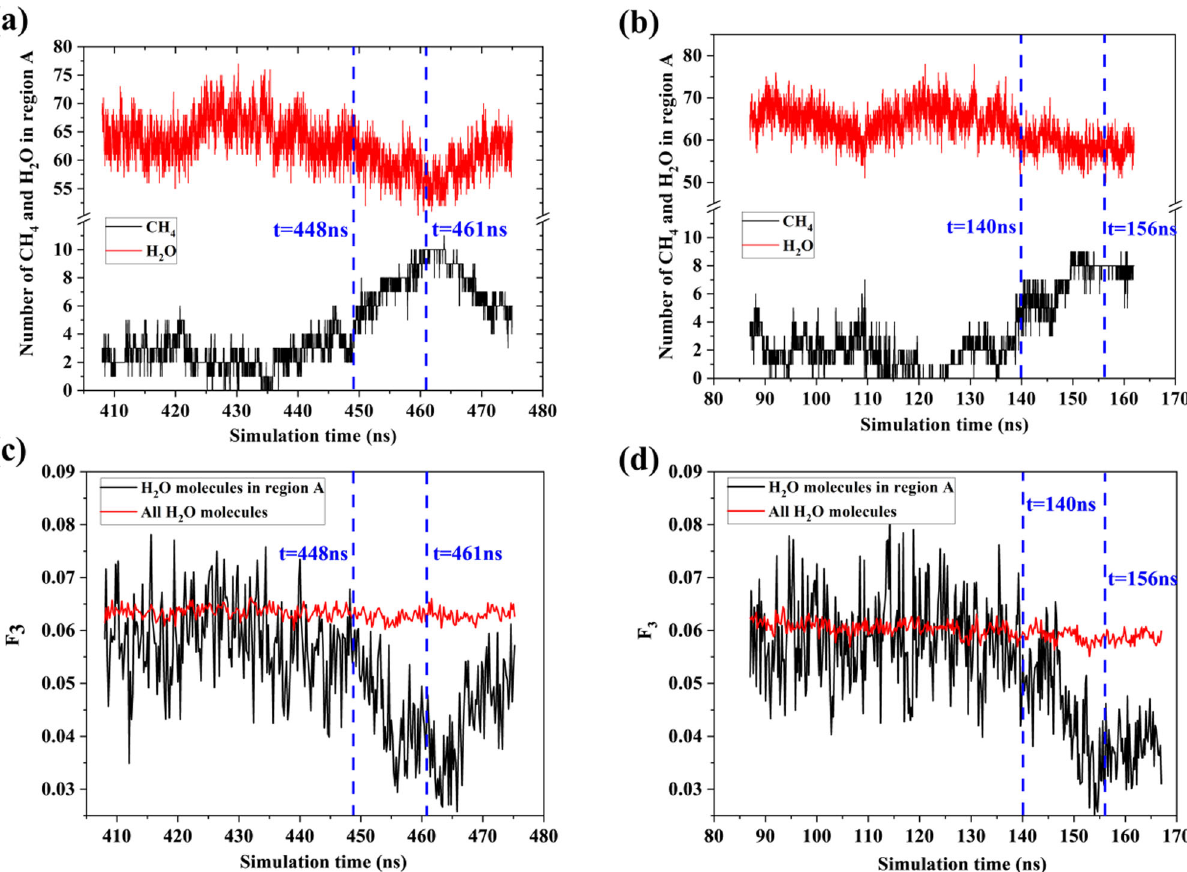
Fig. 4 Methane distribution around central methane in boxes A and C. a , b The numbers of methane and water molecules in region A as a function of simulation time for boxes A and C. c , d Variation of F 3 order parameter for boxes A and C. Both results for all water and water in region A are shown. e Change of numbers of methane and water molecules in the L1 – L5 layers for box